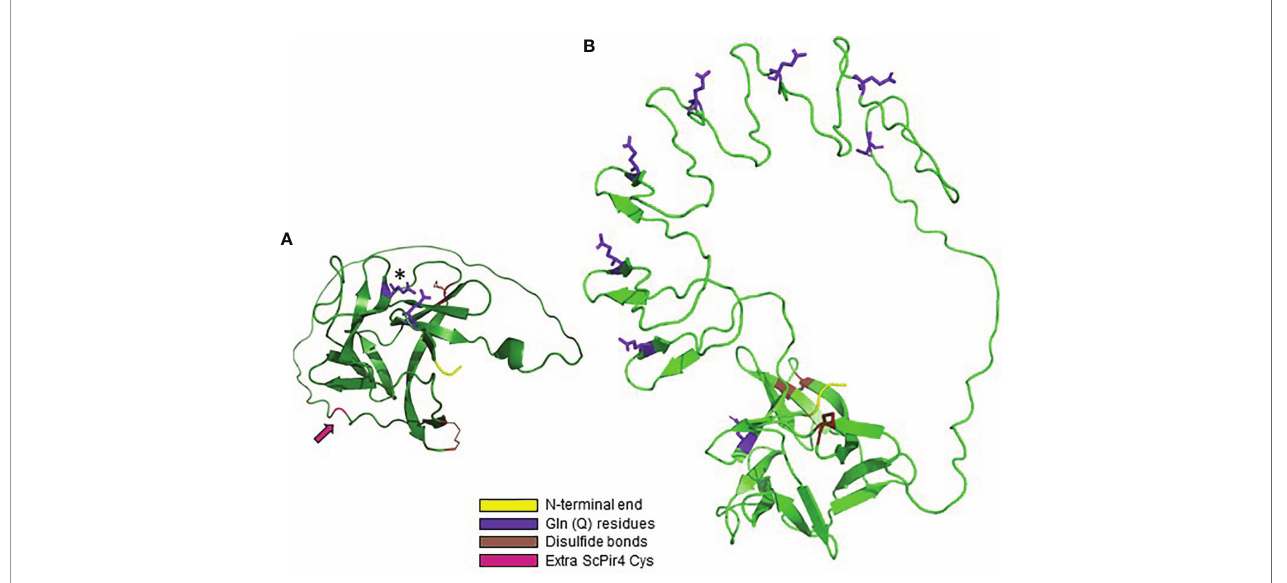
FIGURE 7 | AlphaFold structural predictions for S. cerevisiae Pir proteins. (A) ScPir4, processed to remove the secretory signal peptide and to re fl ect Kex2 cleavage. The mature protein began at amino acid 65; the N-terminal sequence of the mature protein (DVI) is highlighted in yellow. The Gln (Q74) residue that forms a carboxyl ester with b -1,3-glucose is highlighted in purple and marked with an asterisk. Also highlighted in purple is Q160, the N-terminal Gln in the QFQFD motif. ScPir4 Cys residues were predicted to form two disul fi de bonds (C195-C212, C128-C225) highlighted in brown. These Cys residues are conserved in all S. cerevisiae Pir proteins. ScPir4 has 6 Cys residues: one (C41) removed by Kex2 processing and the other (C120; highlighted in magenta and indicated by an arrow) available to form disul fi de bonds with other components of the cell wall, likely explaining release of ScPir4 by b -mercaptoethanol treatment (Castillo et al., 2003). (B) AlphaFold structural prediction for ScPir1 to show the position of repeated units relative to the core region of antiparallel beta-sheets. The start of the mature protein (AAA, highlighted in yellow) re fl ected removal of the secretory signal peptide and Kex2 cleavage. The Gln from each DGQ in the repeated unit was highlighted in purple. Gln from the fi rst repeated unit (Q74) was adjacent to the N-terminal Gln of the QFQFD motif (the latter was not highlighted). The four conserved Cys in ScPir1 were predicted to form two disul fi de bonds (highlighted in